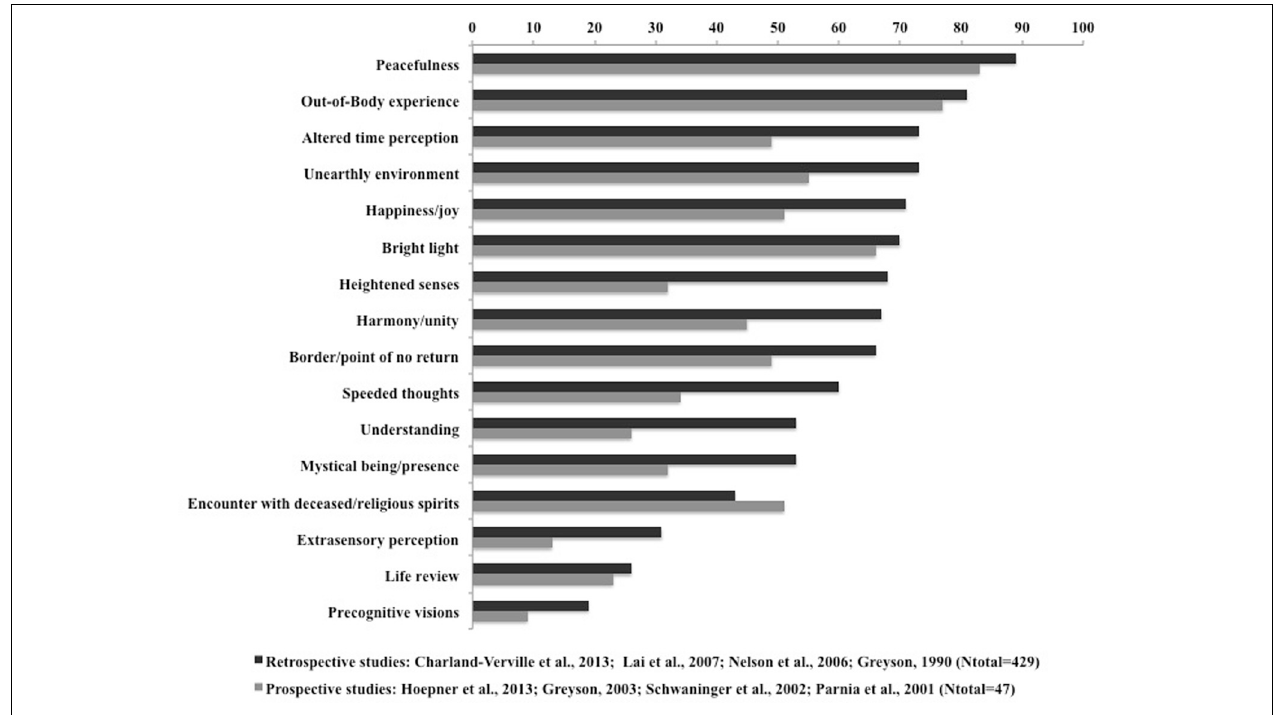
FIGURE 1 | Frequency of NDE features in retrospective and prospective studies (all etiologies) according to the Greyson NDE scale by decreasing order according to the retrospective data.